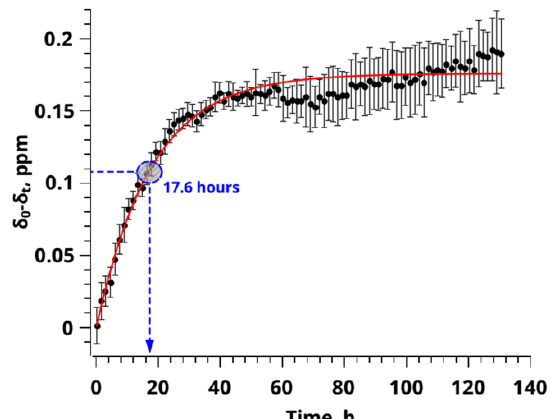
Figure 6. A graph of the change dependence in the parameter of the chemical shift of the 13 C CO 2 signal on time, approximated by a one-exponential model. Where δ 0 is the value of the chemical shift of the 13 C CO 2 signal at the initial time, δ t is the value of the chemical shifts of the 13 C CO 2 signal at observation time t. The blue circle on the graph indicates the correlation time of this sorption process, defined as the reciprocal of the rate constant of the sorption process (k).